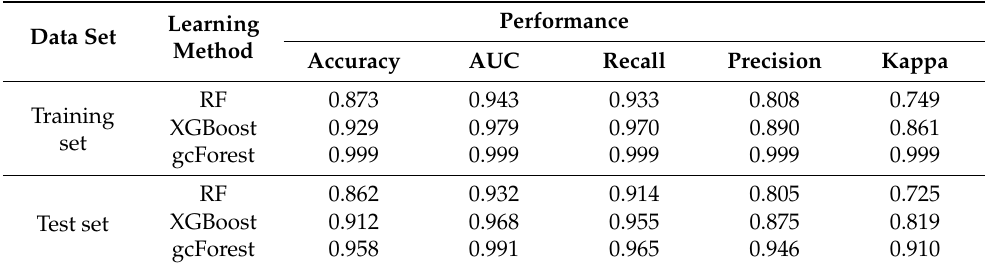
Table 7. Statistical measures of different methods obtained for the training and test